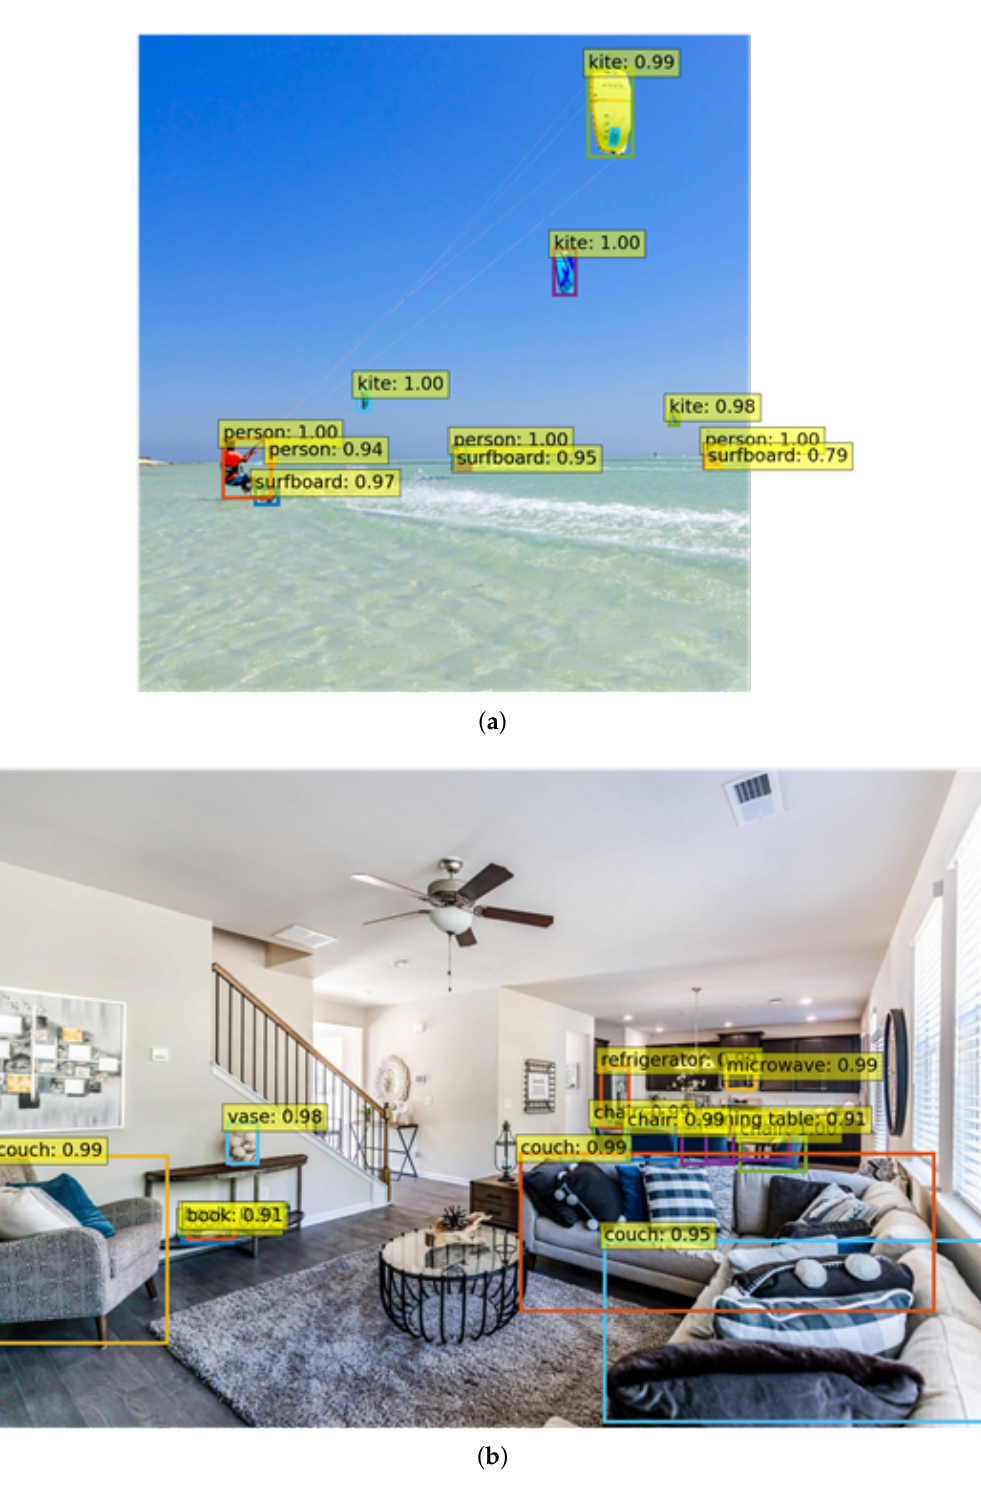
Figure A1. DETR inferences on positive images. ( a ) shows correct detection of COCO objects such as person, surfboard, and kite located in varying scales and sizes within the image. ( b ) shows a challenging scene including small and crowded COCO objects such as book, chair, dining table, microwave, etc. The qualitative examples show the effectiveness of the base model (DETR trained on COCO) used for transfer